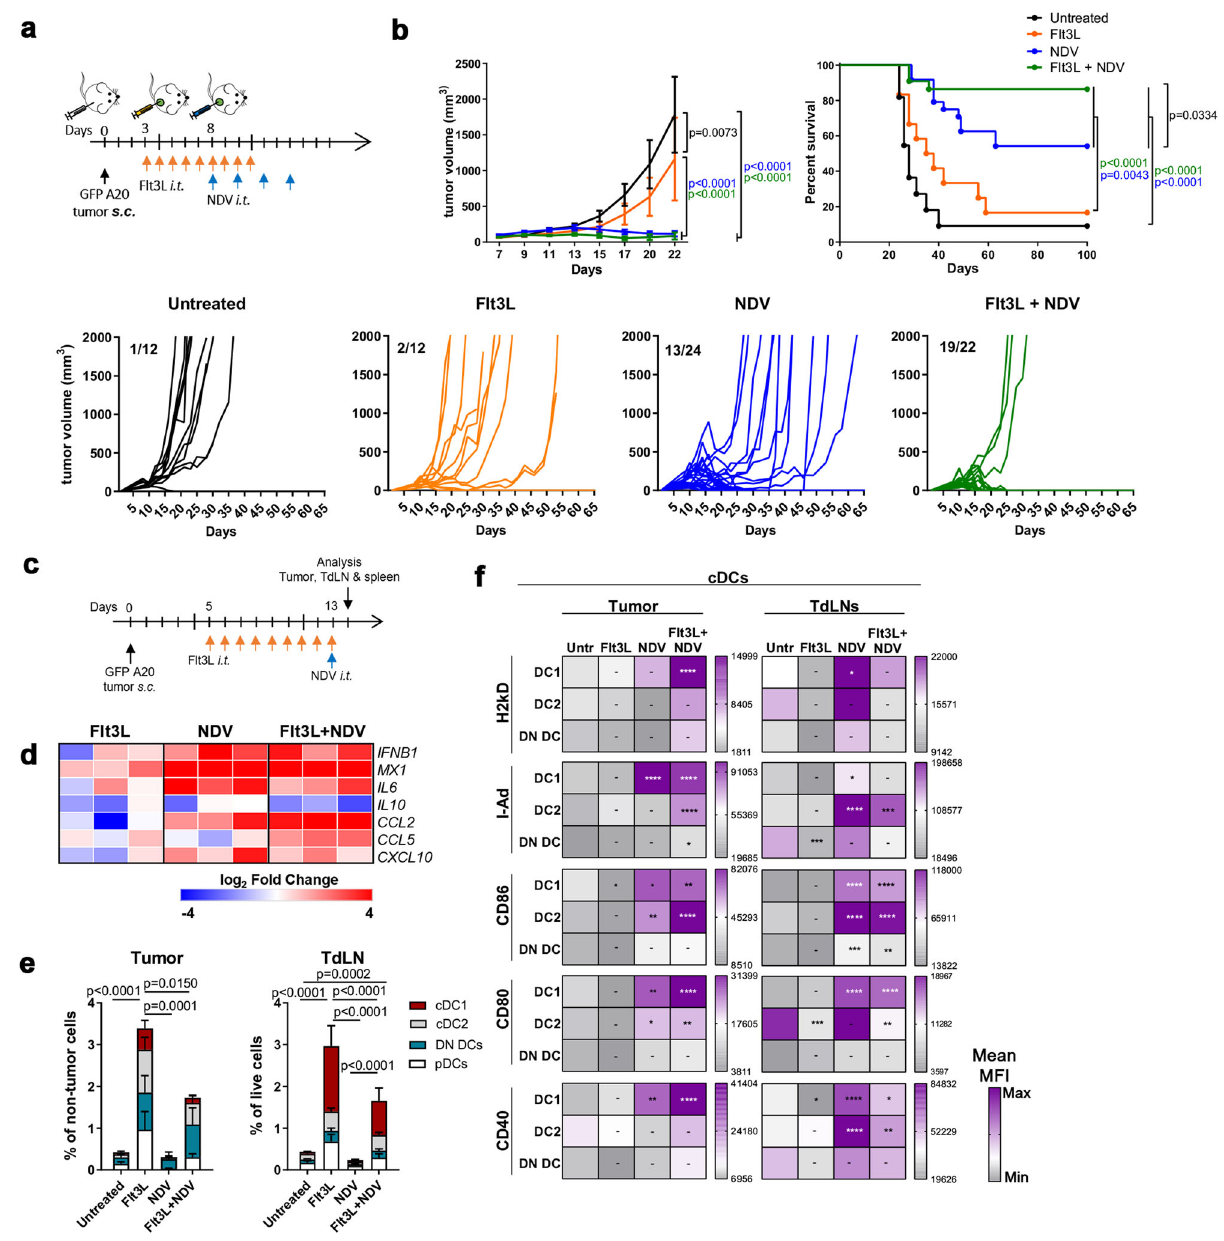
Fig.3|NDVtherapyinDC-enrichedtumorspotentiatesmyeloidactivationand tumorregressions. a GFP + A20 tumor-bearing mice were treated